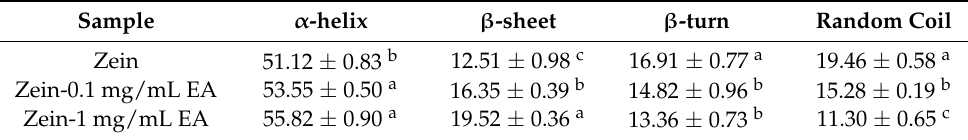
Table 4. Fractions of secondary structure of zein in the absence and presence of